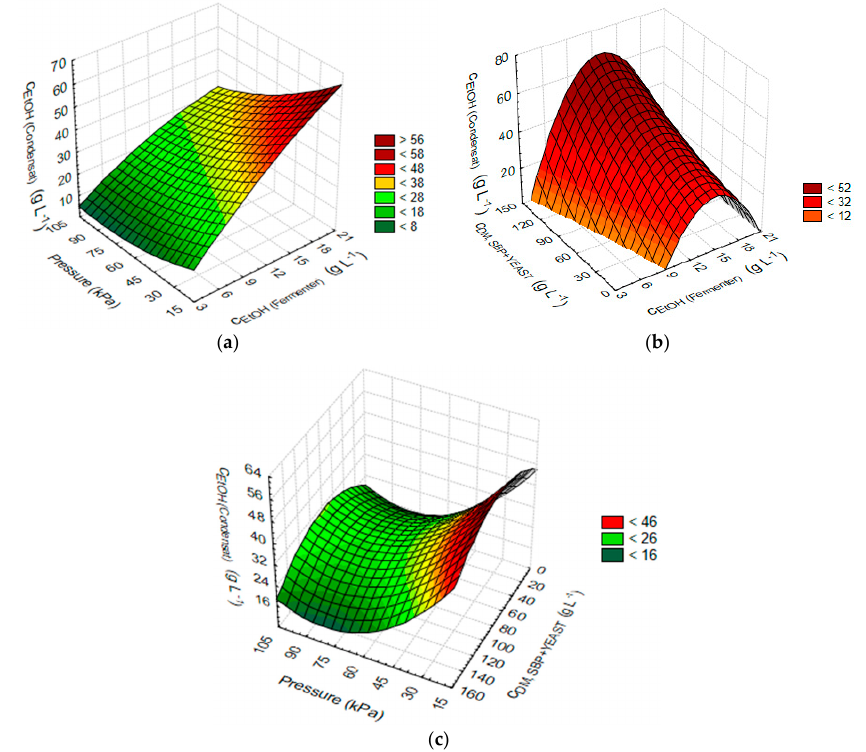
Figure 4. Changes of ethanol concentration in the vacuum assisted gas stripping recovery step with investigated factors (vacuum rate, solid and ethanol concentration) ( a – c ).